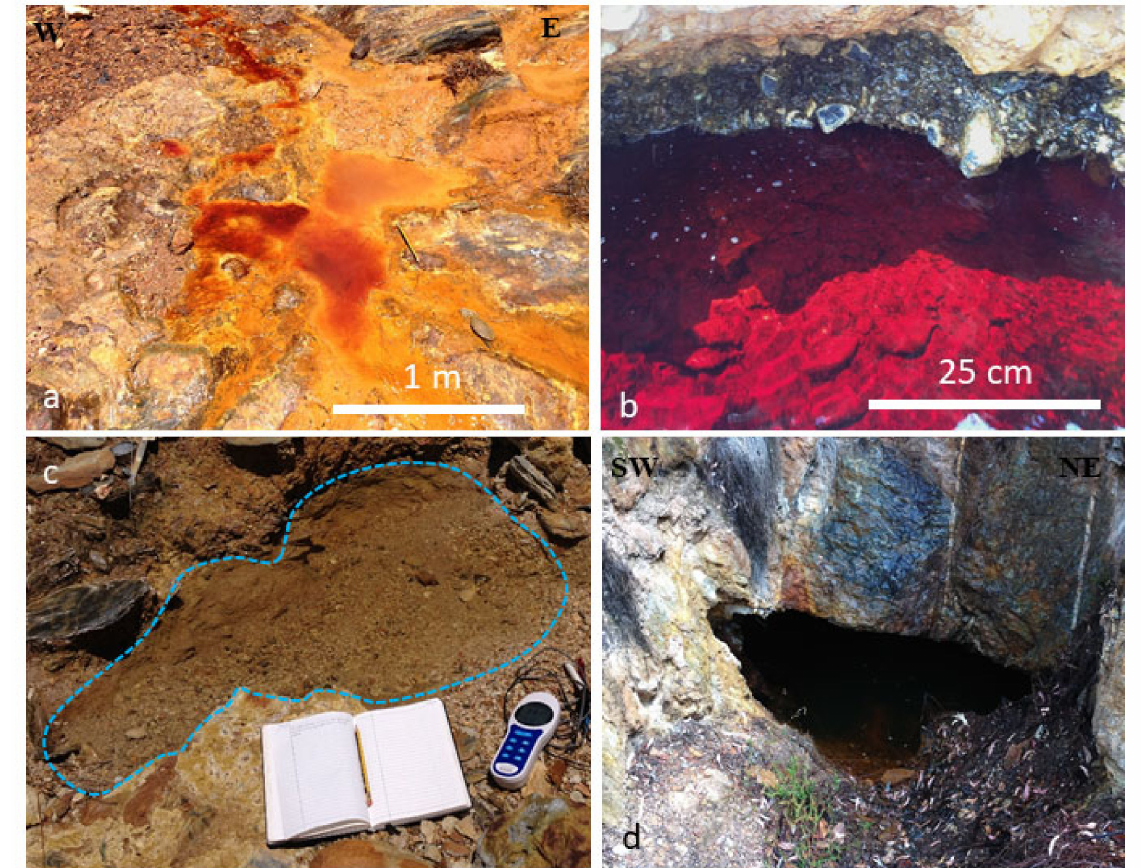
Figure 9. Water color of streams and springs in some headwater location. ( a ) The confluence of the Left (clear orange) and Right (murky orange) tributaries highlighting the precipitation of nanophase iron oxyhydroxides as a result of the mixing of lower and higher pH waters. ( b ) Deep red waters of the Valley of the Crazies (VOTC). ( c ) Colorless waters of the Left Richi Spring, with the blue boarder denoting the boundary of the pool. ( d ) Cave waters are evidently a clear but murky color.